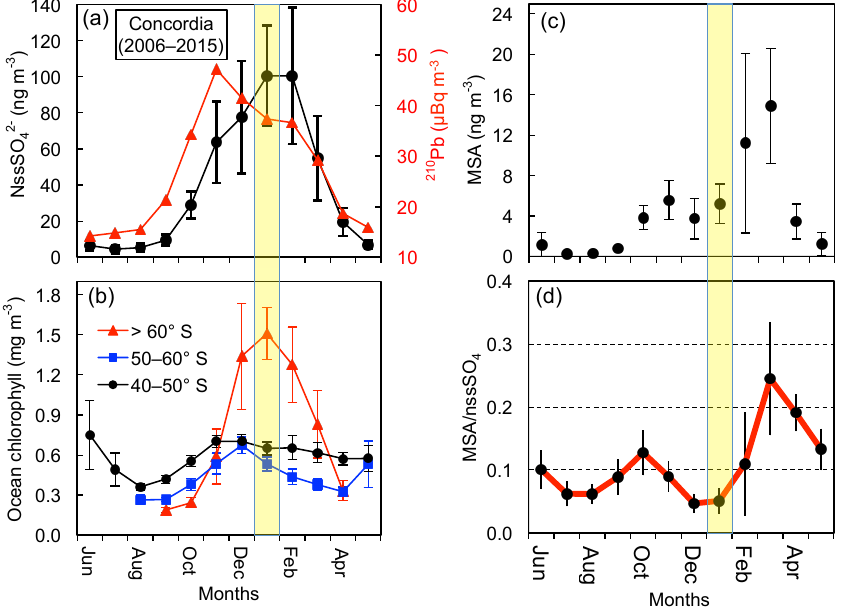
Figure 2. Monthly mean concentration of nssSO 4 along with 210 Pb level (a) , MSA (c) , and MSA / nssSO 4 ratio (d) in bulk aerosol collected at Concordia from January 2006 to January 2016. (b) Monthly mean chlorophyll concentration in the Southern Ocean (2002–2011) (MODIS- Aqua satellite data as reprocessed by Johnson et al., 2013). Vertical bars denote year-to-year